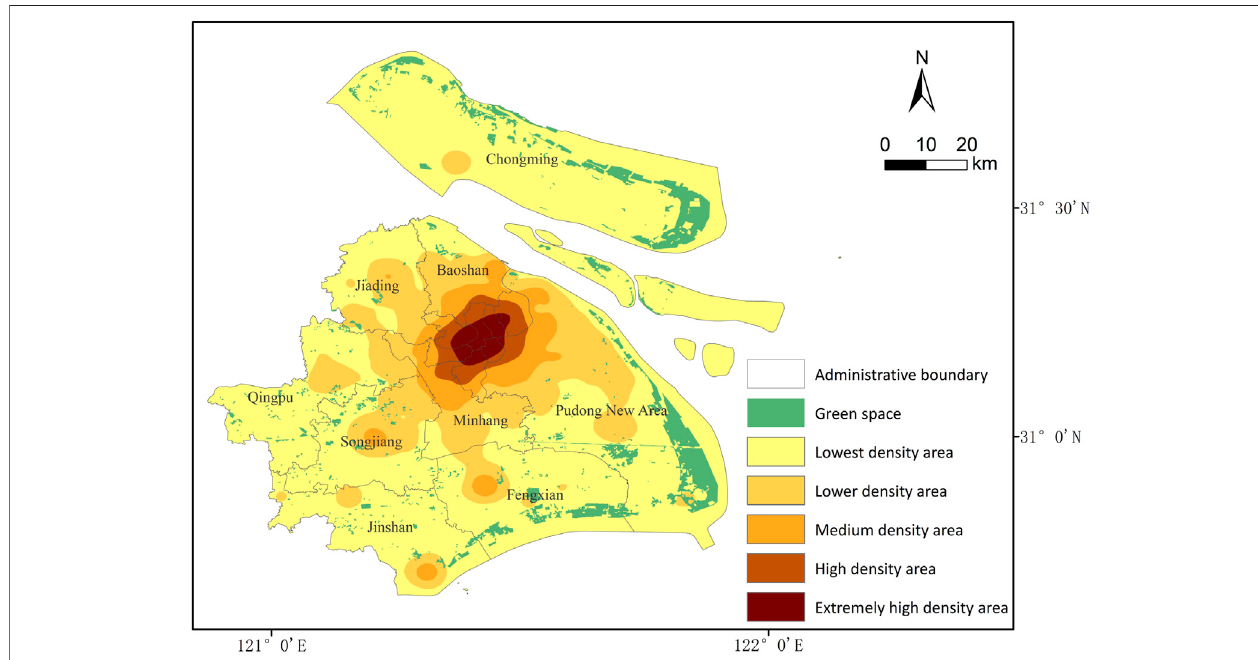
FIGURE 2 | Distribution of GSS overlapped by production and living density based on the